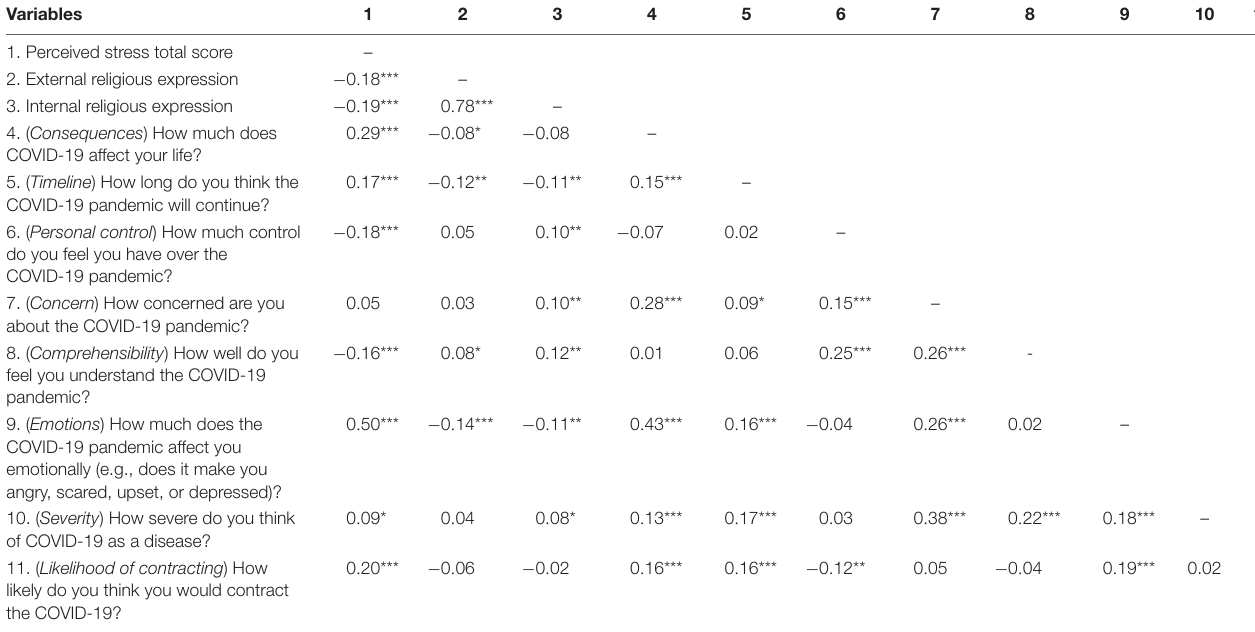
TABLE 3 | Correlation matrix of perceived stress, religious expression, and illness perception.